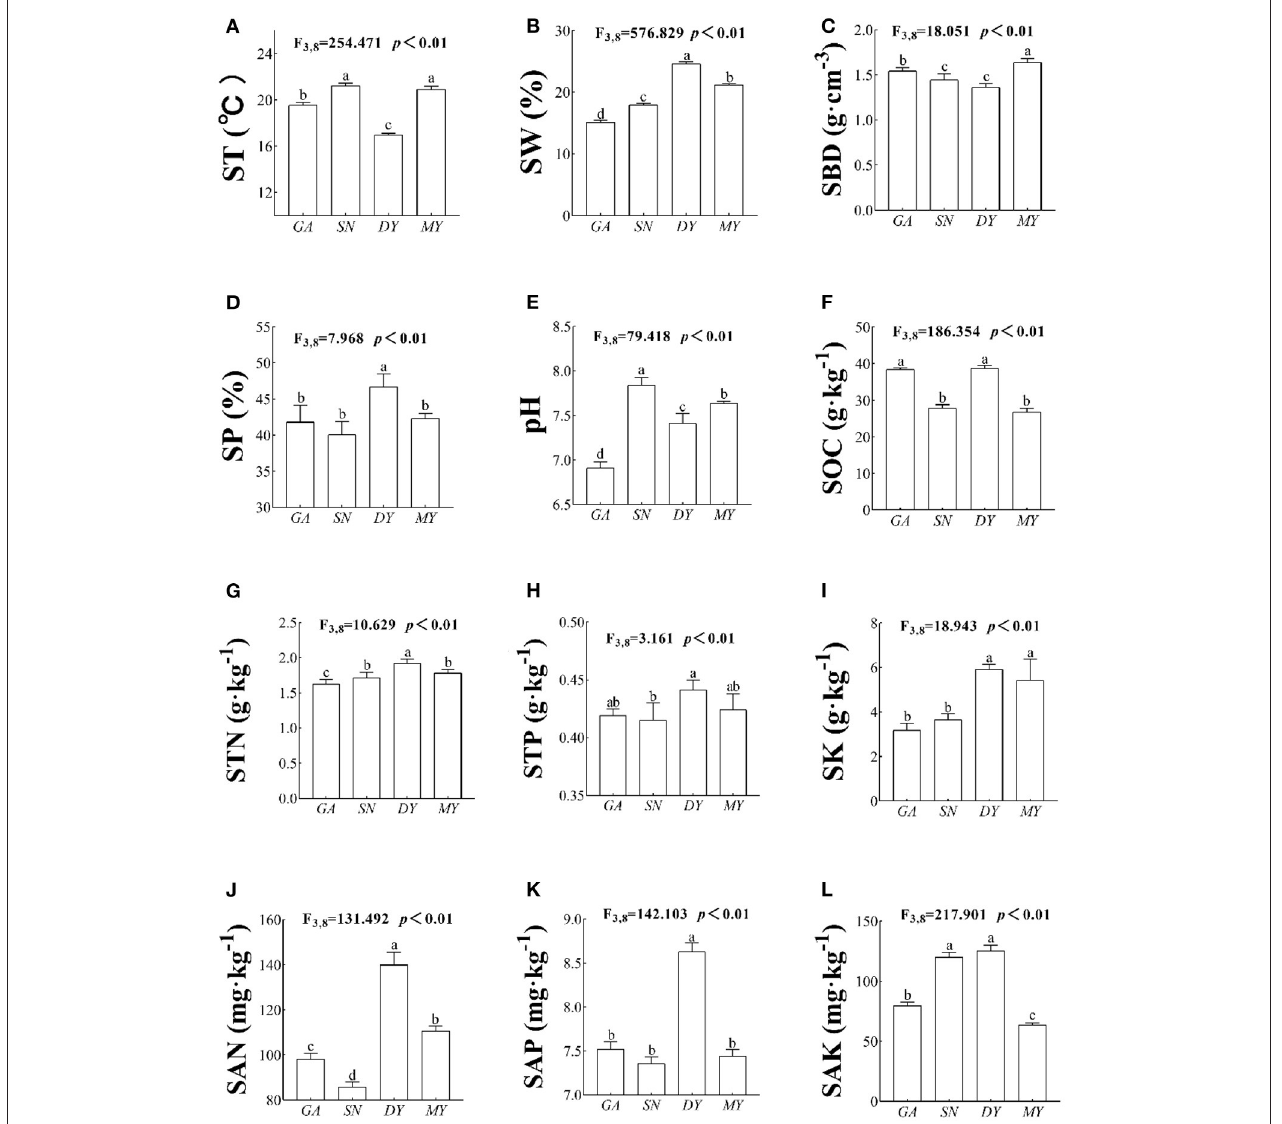
FIGURE 2 | Soil physicochemical parameters in four sites. DY, Deyang City; GA, Guang’an City; MY, Mianyang City; SN, Suining City. The RSA index variables are (A) ST, soil temperature; (B) SW, soil water content; (C) SBD, soil bulk density; (D) SP, soil porosity; (E) pH, soil pH; (F) SOC, soil organic carbon; (G) STN, soil